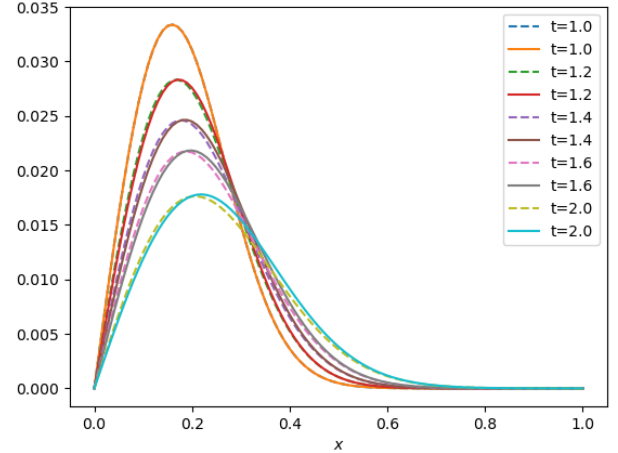
Figure 8. Shock propagation ν = 0.01 and N = 100.